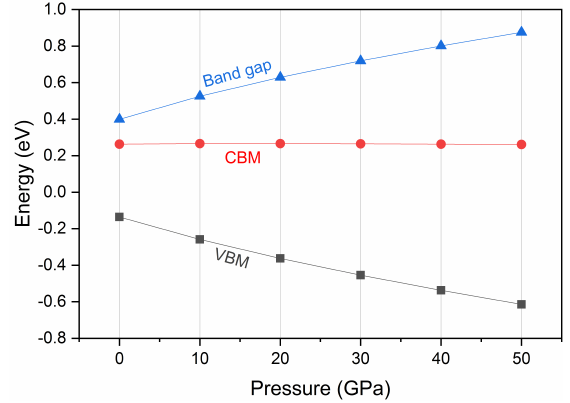
Figure 4. The conduction band minimum (CBM), valence band maximum (VBM) and band gap in the minority spin channel of Ti 2 NiIn compound under different